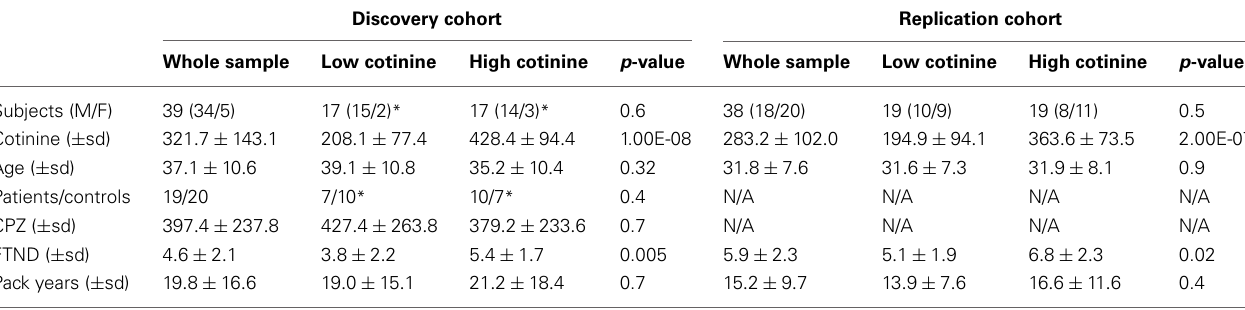
Table 1 | Subjects’ demographic and clinical information including gender, age, cotinine level, current antipsychotic medication dose, as calculated by chlorpromazine equivalent (CPZ), and Fagerstrom Test for Nicotine Dependence (FTND) scores, a measure of smoking addiction